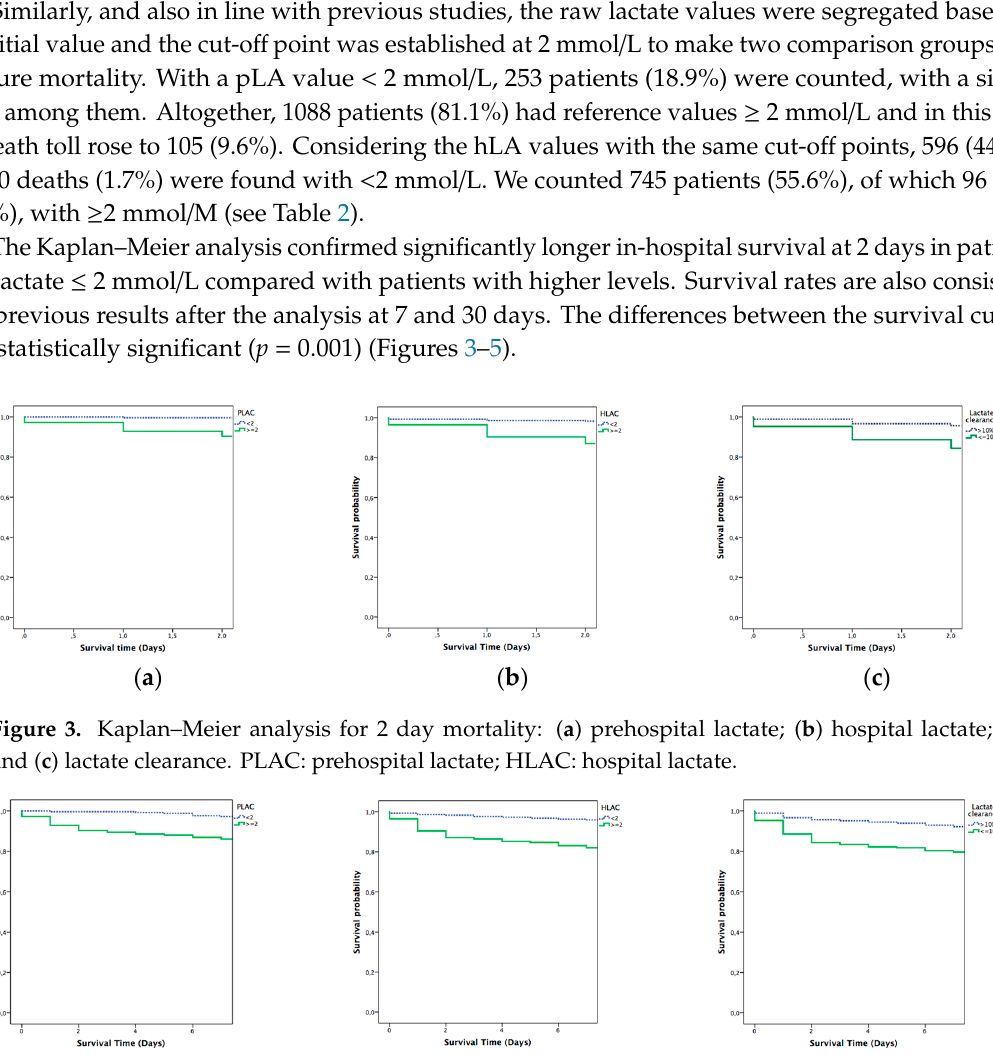
Table 2. Correlation between Δ LA and 2 day mortality.